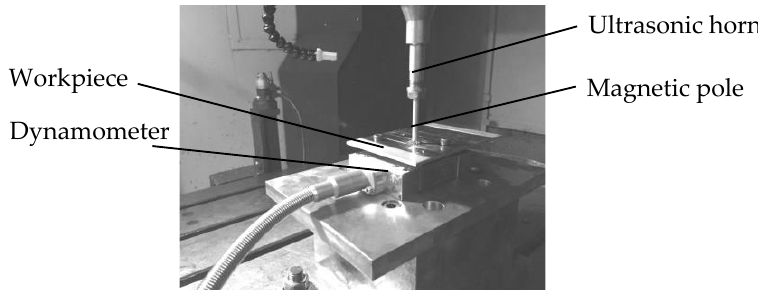
Figure 4. Experiment setup of UAMAF. Table 1. Mechanical properties of TC4.